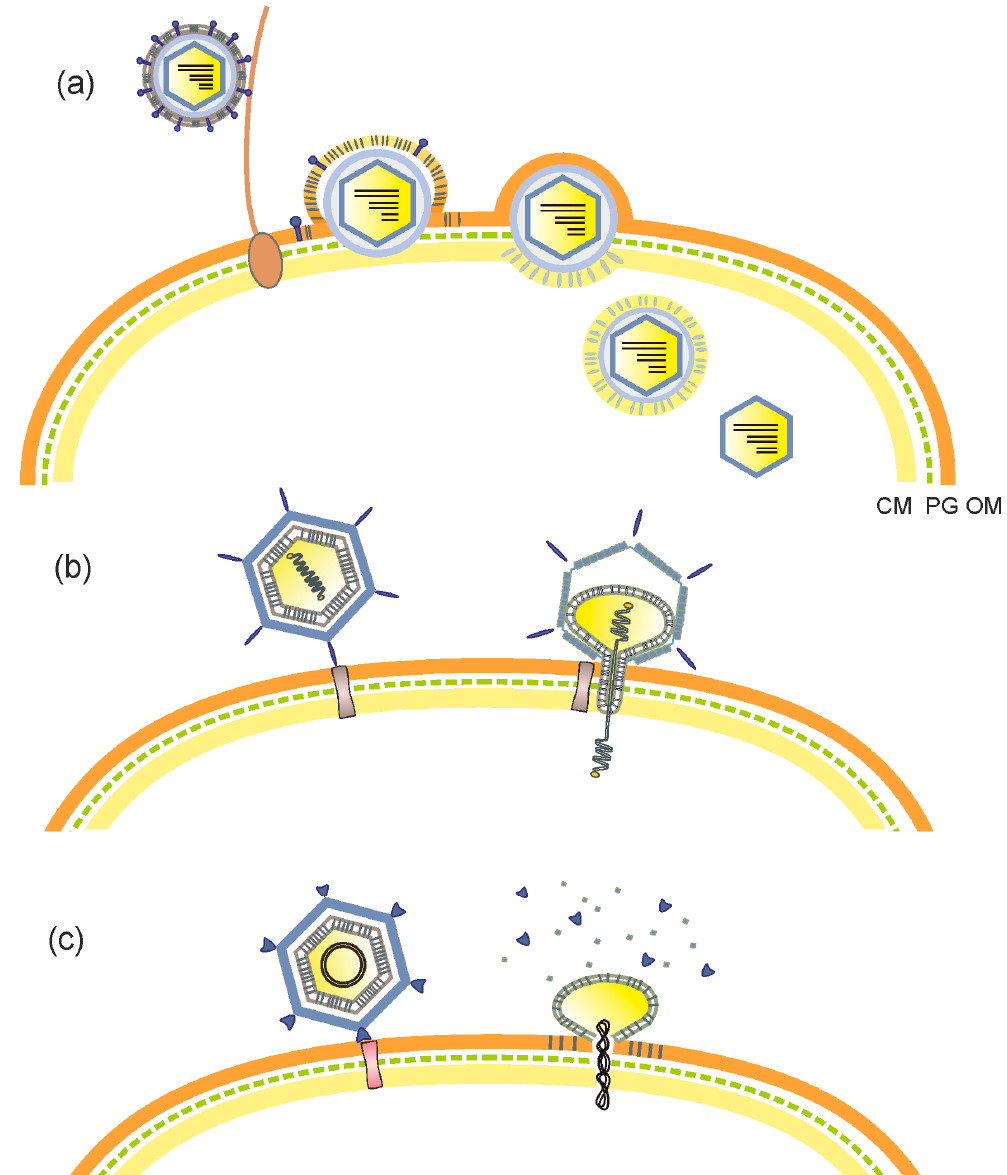
Figure 1. Entry mechanisms of membrane-containing phages. ( a ) Pseudomonas phage phi6. Phi6 attaches to a type IV pilus, which retracts and brings the virion into contact with the bacterial outer membrane. The viral membrane (envelope) fuses with the host outer membrane, releasing the nucleocapsid into periplasmic space. The peptidoglycan layer is digested by a virally-encoded lytic enzyme, after which the nucleocapsid enters the cytoplasm via an endocytic-like route. Finally, the nucleocapsid shell dissociates, releasing the phi6 virion core (polymerase complex). ( b ) Pseudomonas phage PRD1. Upon attachment to the host receptor, the internal membrane vesicle of phage PRD1 transforms into a proteo-lipidic tube, which traverses the cell envelope and provides a conduit for transferring the linear dsDNA genome into the cytoplasm. ( c ) Pseudoalteromonas phage PM2. It has been suggested that after phage PM2 binds to the host receptor, its protein capsid dissociates triggering the fusion between the internal membrane vesicle and the bacterial outer membrane and consequently the release of the circular dsDNA genome into the cell. CM, cytoplasmic membrane; PG, peptidoglycan layer; OM, outer membrane of the envelope in Gram-negative host bacterium.